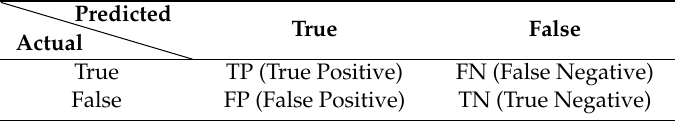
Table 5. Confusion matrix for evaluating the pothole classification.